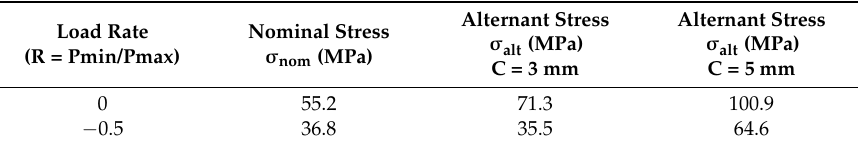
Table 5. Nominal and alternant stresses for the fatigue